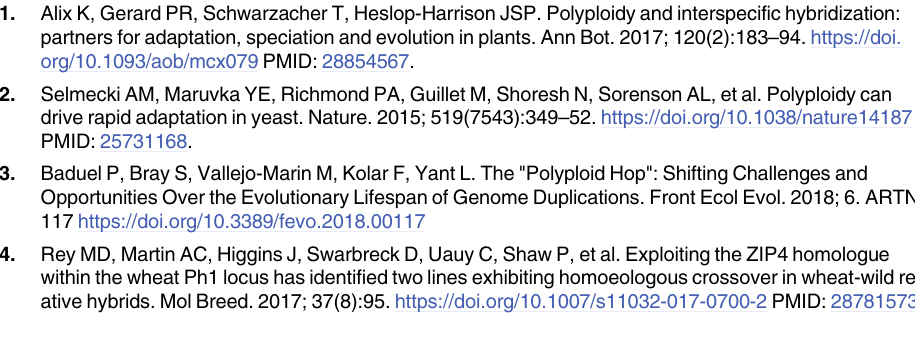
S6 Table. Meiosis genes from A . lyrata reference genome S7 Table. Data for figures. Raw data used for generating